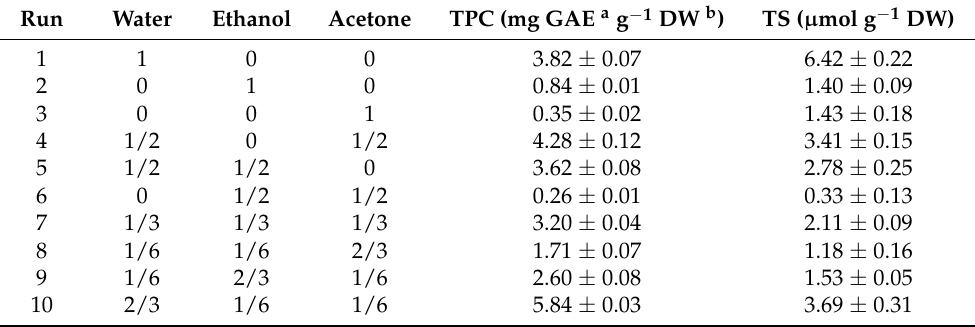
Table 2. Total phenolic compound (TPC) and thiosulfinate (TS) content of the different solvent mixtures